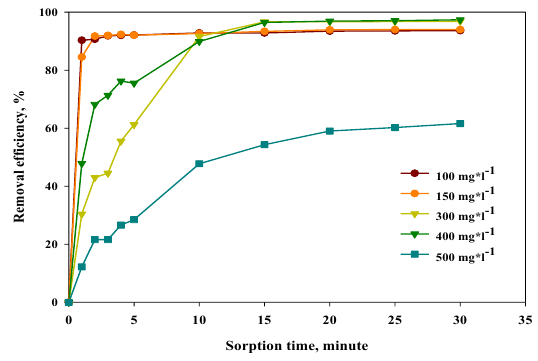
Fig. 3. Relationship between sorption capacity and sorp- tion time ( рН=6.0, sorbent mass: 0.2 g, room